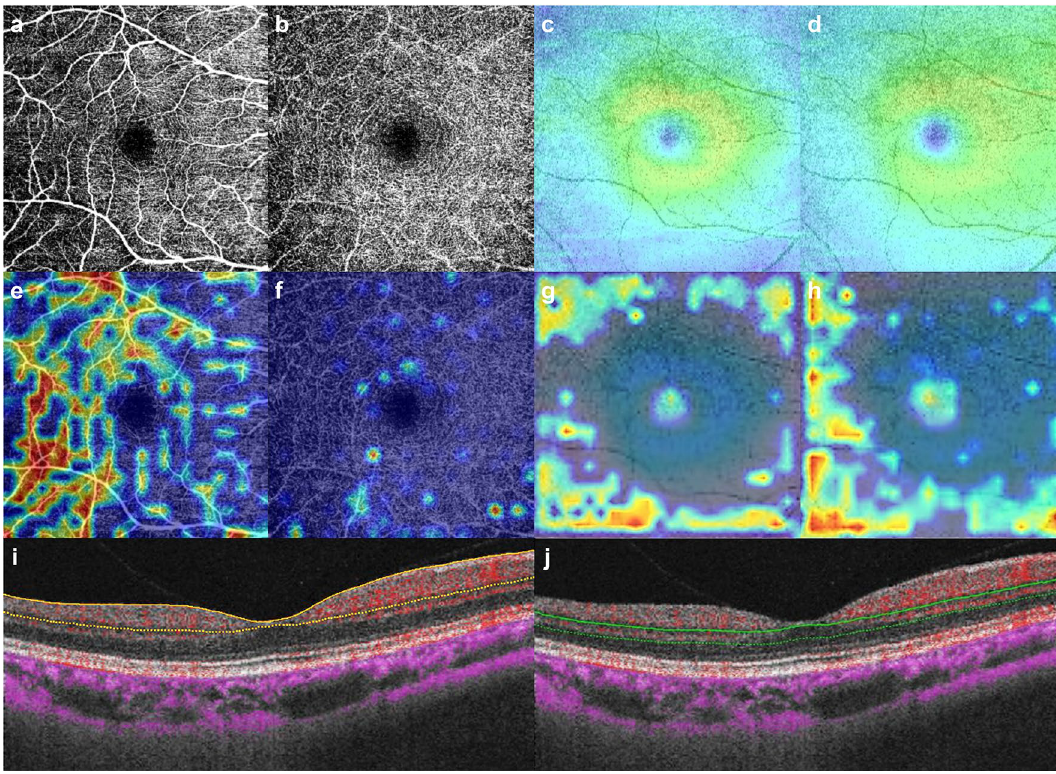
Figure 2. Macular OCT angiography (OCTA) and OCT images with heatmaps for prediction of highly myopic glaucoma by trained deep learning (DL) model. ( a ) OCTA superficial capillary plexus (SCP) image. ( b ) OCTA deep capillary plexus (DCP) image. ( c ) OCT GCL+ (ganglion cell layer + inner plexiform layer) image. ( d ) OCT GCL++ (retinal nerve fiber layer + ganglion cell layer + inner plexiform layer) image. ( e – h ) Heatmaps for OCTA SCP, OCTA DCP, OCT GCL+ and OCT GCL++ images, respectively (shown in first row). The heatmap revealed that the areas of microvasculature dropout with decreased vessel density were mainly highlighted in the OCTA SCP image ( e ), those areas being the main contributor to the model’s determinations. However, the heatmap was poorly activated in the OCTA DCP image ( f ). In the heatmaps for the OCT GCL+ ( g ) and GCL++ images ( h ), the regions where their thickness was decreased were highlighted. Corresponding B-scans with flow overlay (in red) of SCP (between the yellow lines; from 2.6 μm below the internal limiting membrane to 15.6 μm below the junction between the inner plexiform and the inner nuclear layers) ( i ) and DCP (between the green lines; from 15.6 μm below the inner plexiform and inner nuclear layers to 70.2 μm below them) ( j